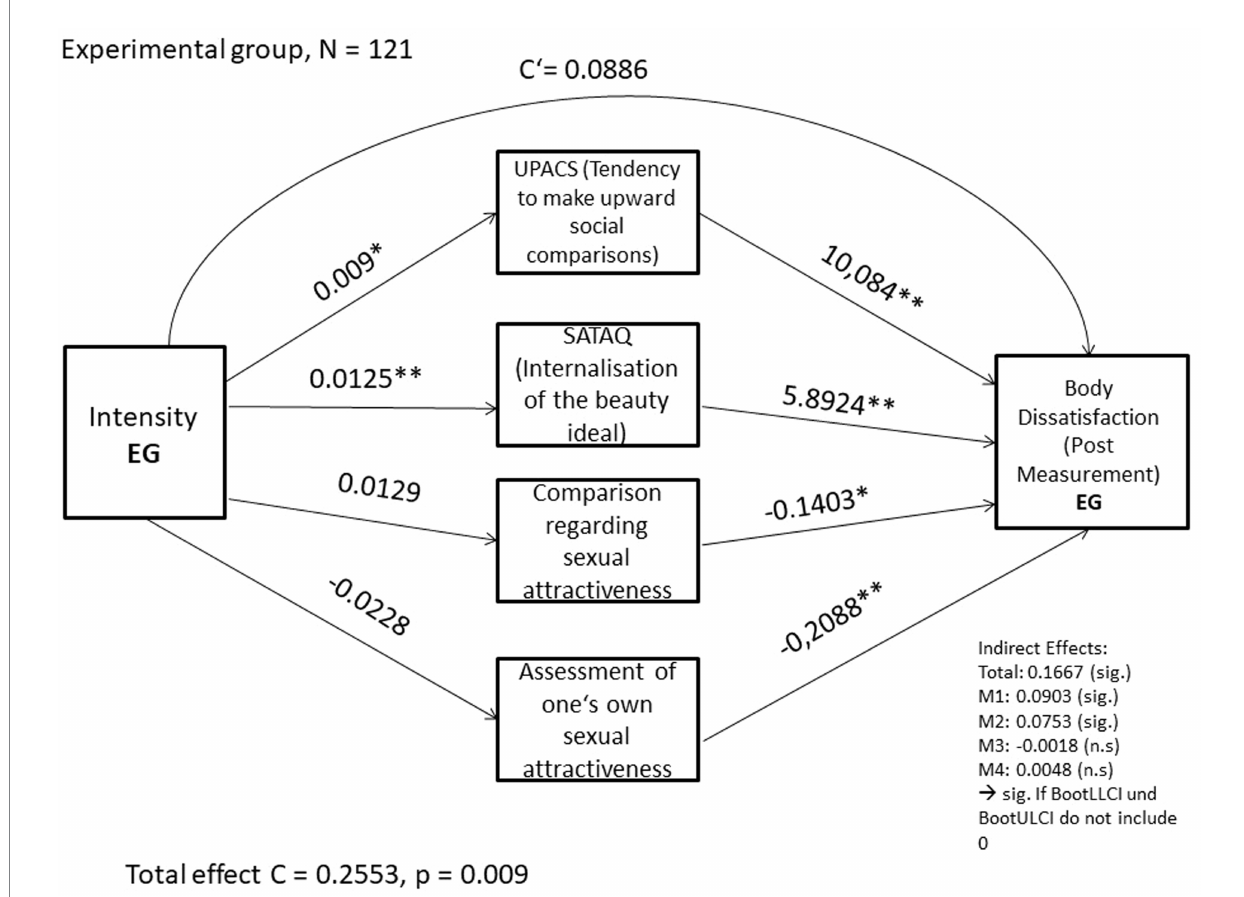
FIGURE 2 Calculated mediation model for the experimental group. The asterisks behind the coefficients indicate the significance level: * p < 0.05, ** p <